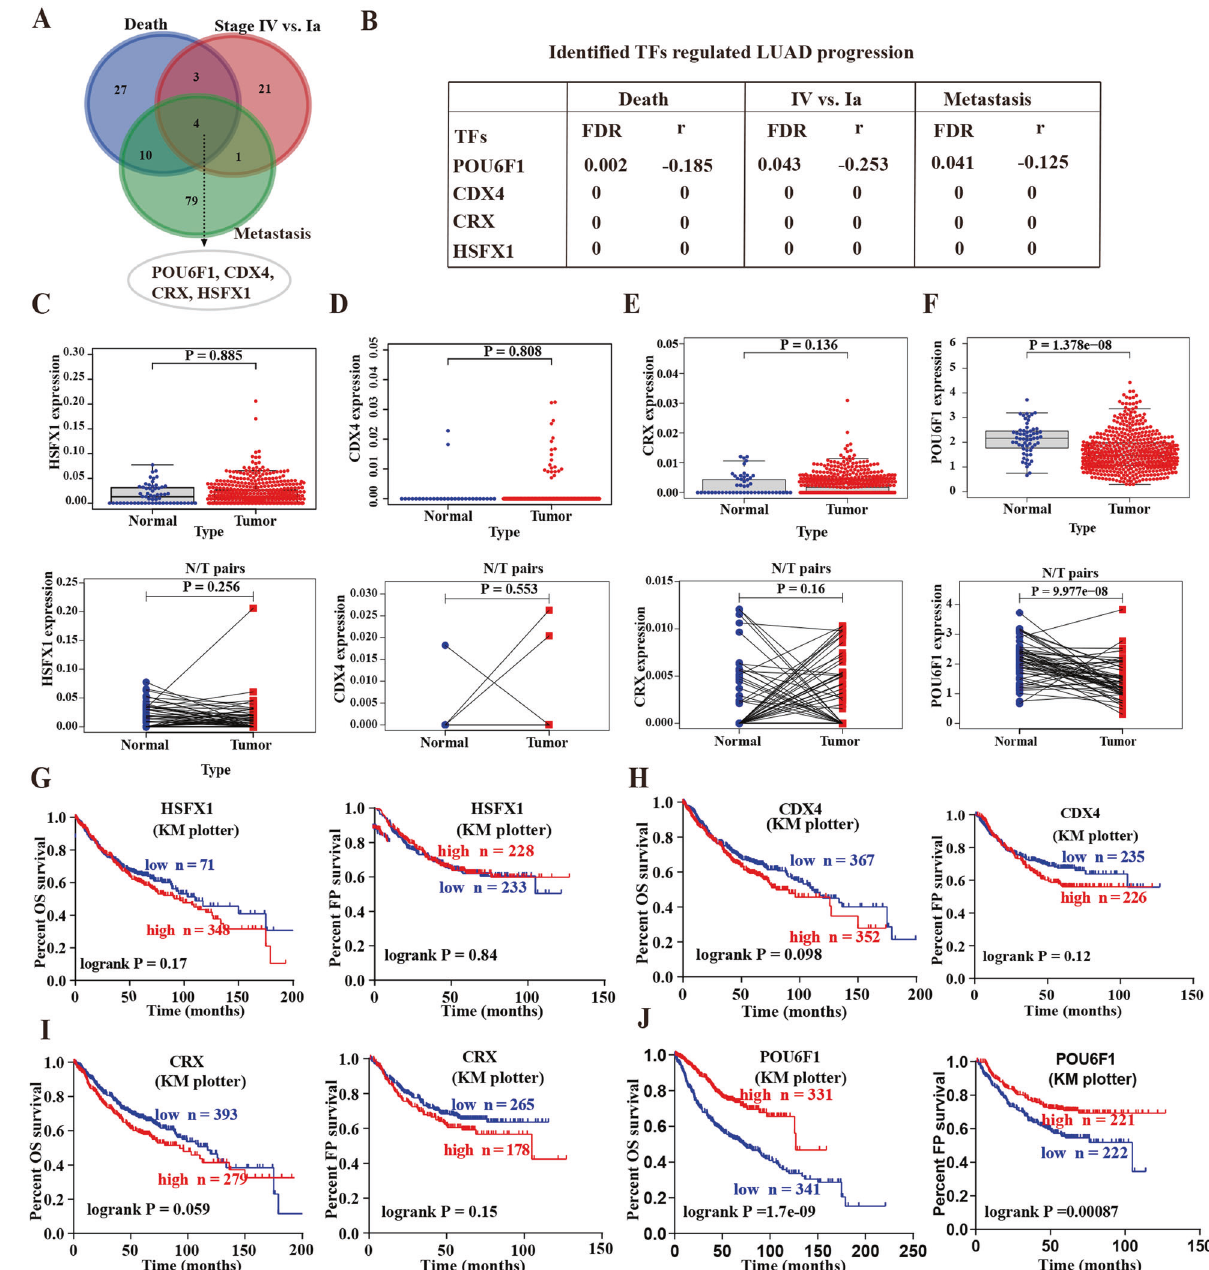
Fig. 1 POU6F1 is identi fi ed as the potential transcription factor for regulating LUAD progression. A , B The potential transcription factors differentially expressed ( P < 0.05) in 515 LUAD cases with the various status of death, clinical stage, or metastasis. C – F Scatter plot showing expression of HSFX1 ( C ), CDX4 ( D ), CRX ( E ), and POU6F1 ( F ) in unpaired (upper panel) or paired LUAD tissues (lower panel) compared with normal tissues. G – J Kaplan – Meier curves indicating overall survival (OS) and fi rst progression (FP) of LUAD patients with high or low levels of HSFX1 (cutoff values = 25.00 and 24.00), CDX4 (cutoff values = 10.00 and 11.00), CRX (cutoff values = 5.00 and 5.00), and POU6F1 (cutoff values = 82.00 and 98.00) derived from Kaplan – Meier Plotter